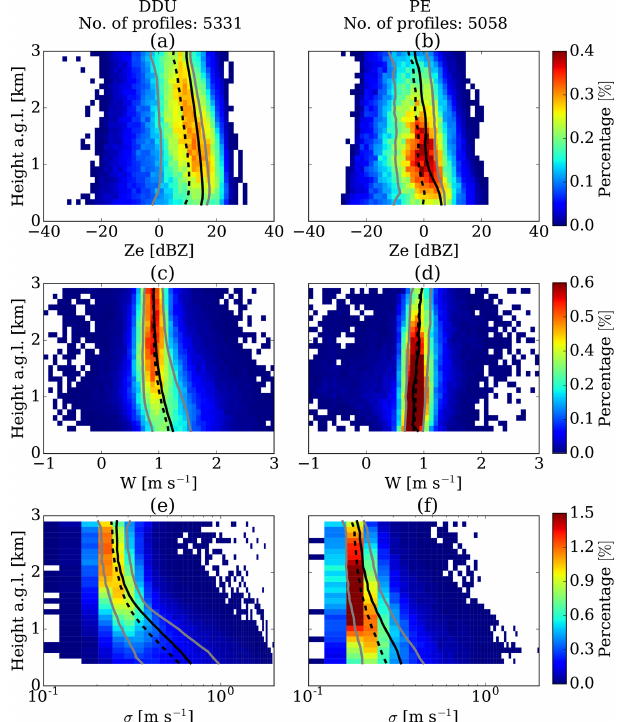
Figure 3. Frequency by altitude diagram for Ze (a, b) , W (c, d) , and σ (e, f) values observed at DDU (a, c, e) and PE (b, d, f) . Solid black and dashed black lines represent the average and median vertical profiles of Ze, W , and σ . Grey lines correspond to the 20% and 80% quantiles of the vertical profiles. σ values are plotted on the log x axis to highlight the variations for small